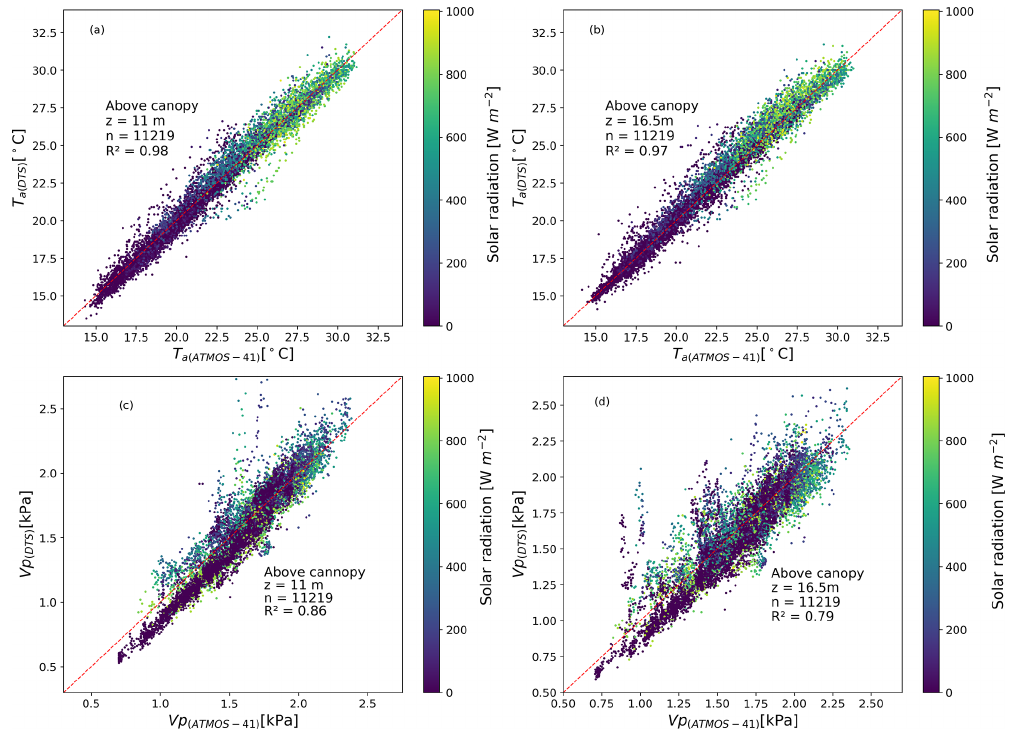
Figure 5. Comparison of DTS temperature ( T a ( DTS ) ) and actual vapour (VP ( DTS ) ) measurements with the ATMOS-41 ( T a(ATMOS-41 ) and VP (ATMOS-41) ) measurements at 11 and 16.5m above the forest